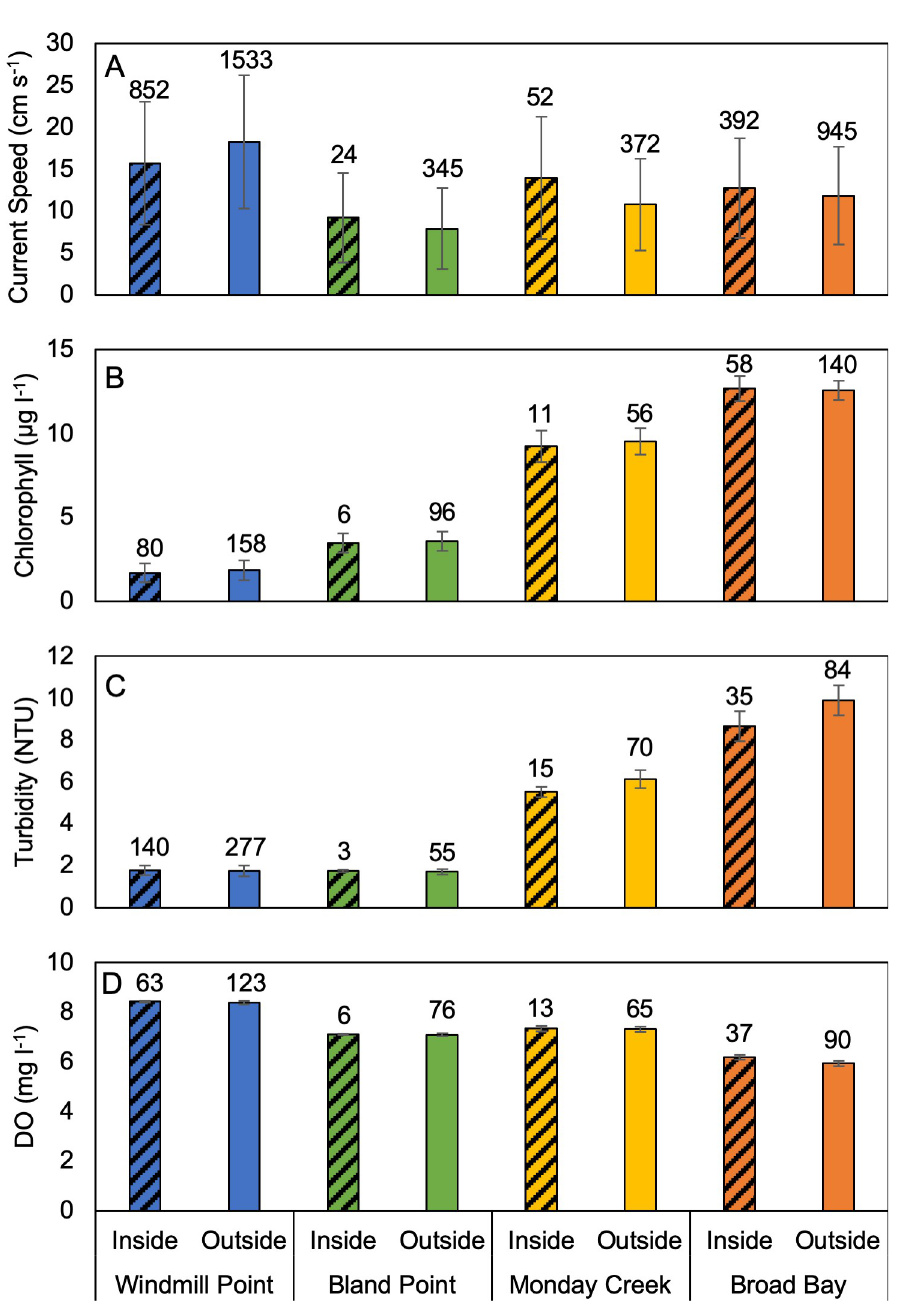
Fig 5. Site comparison of current speed and water quality and during summer 2017. (A) Current speed, (B) chlorophyll, (C) turbidity, and (D) DO. Error bars indicate ± one standard deviation. Sample sizes are shown above each bar. Note that for sites with large sample sizes, α = 0.05 confidence bounds on the means (not shown) are much smaller than the standard